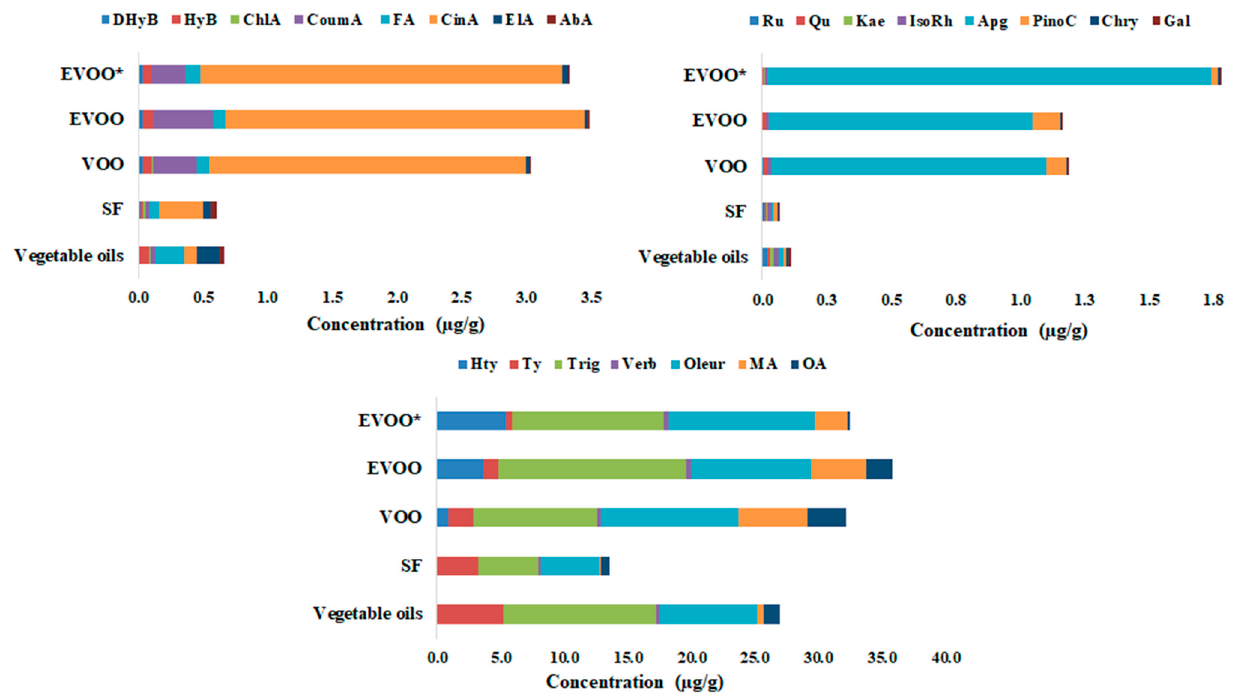
Figure 2 . Biophenolic and triterpenic acids profiles of authentic extra-virgin olive oils (EVOO*), extra-virgin olive oils (EVOO) and virgin olive oils (VOO) compared with sunflower oils (SF) other vegetable oils (average values for grape seeds, pumpkin, linseed, sesame, hemp, rape, walnut, palm, rice, almond, coconut and soybean oils) .